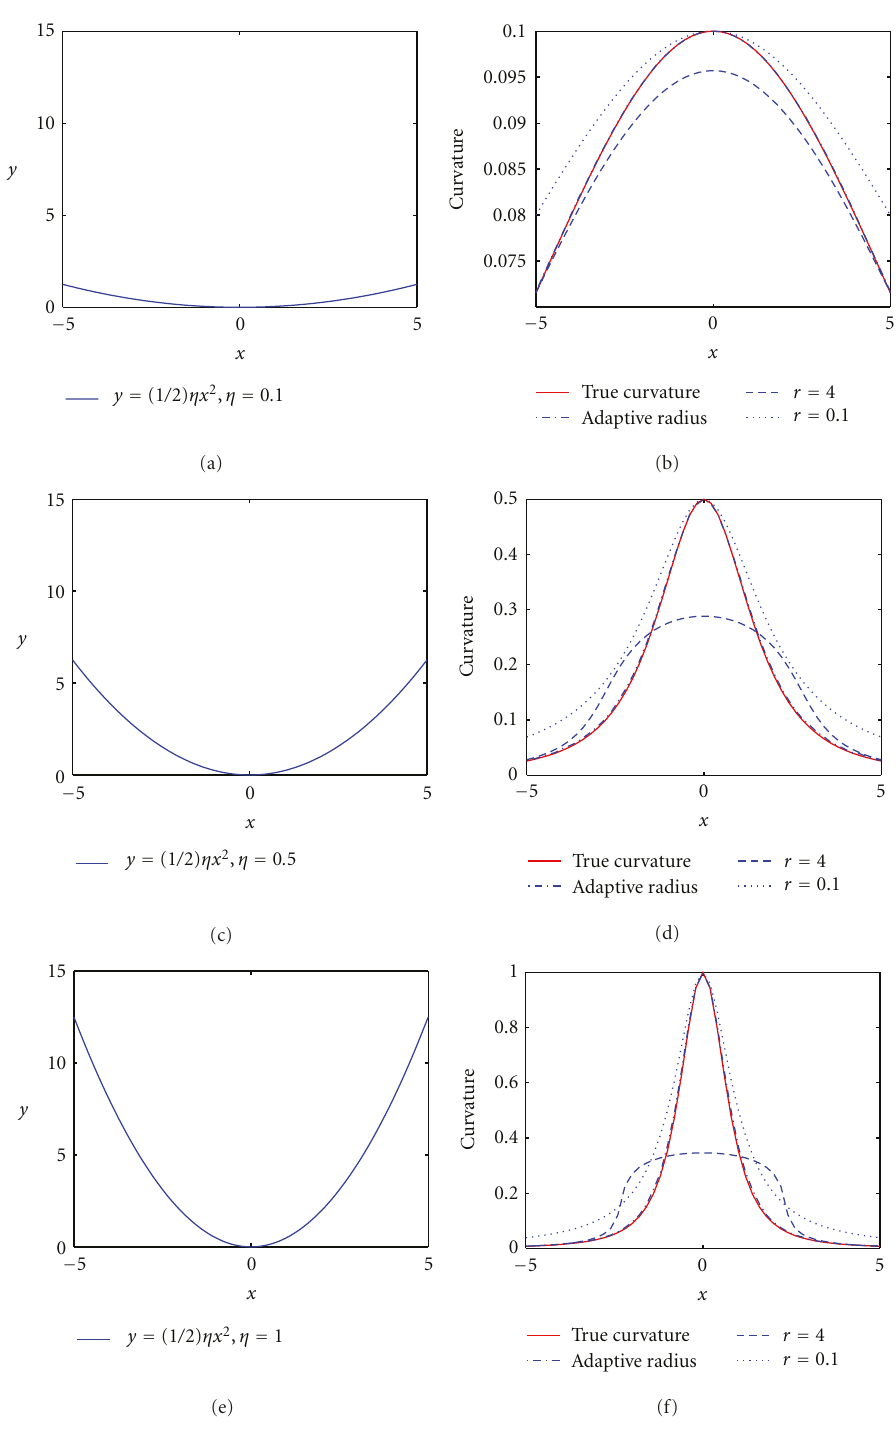
Figure 4: True curvatures and estimated curvatures of the curves in (a), (c), and (e) are shown in (b), (d), and (f), respectively. The curvature estimates are obtained by an adaptive radius and fixed